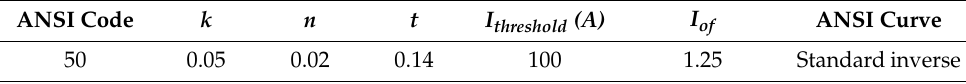
Table 1. Overcurrent relay parameters.